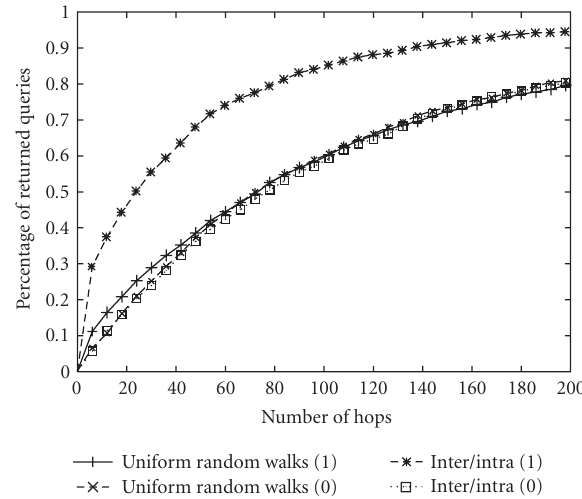
Figure 8: The percentage of returned query within a specific mes- sage number.